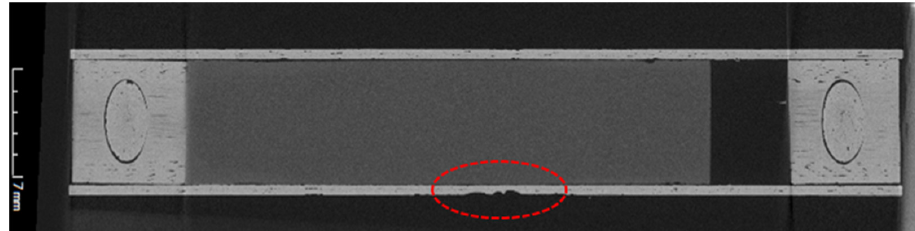
Figure 6. X-ray tomography (longitudinal cut) of the sample after the transient test up to 1845 °C.